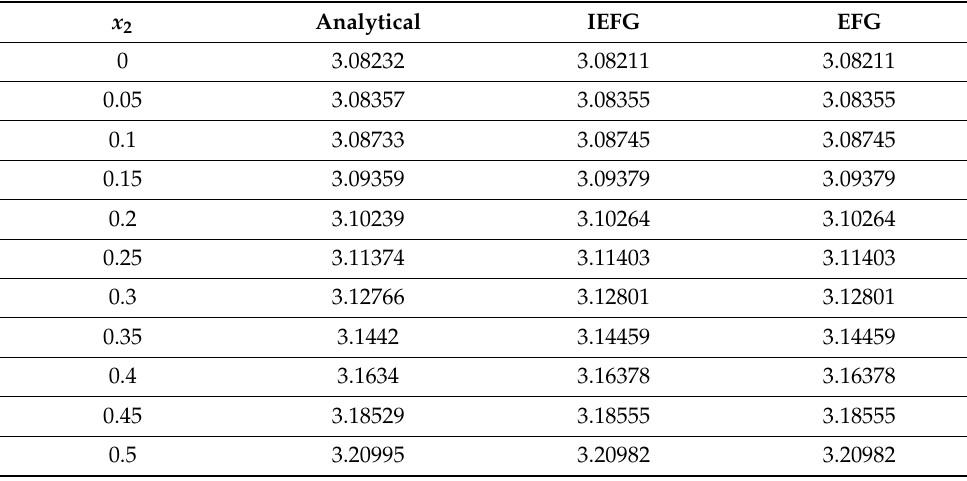
Table 3. The exact and numerical solutions of u (8/20, x 2 ,